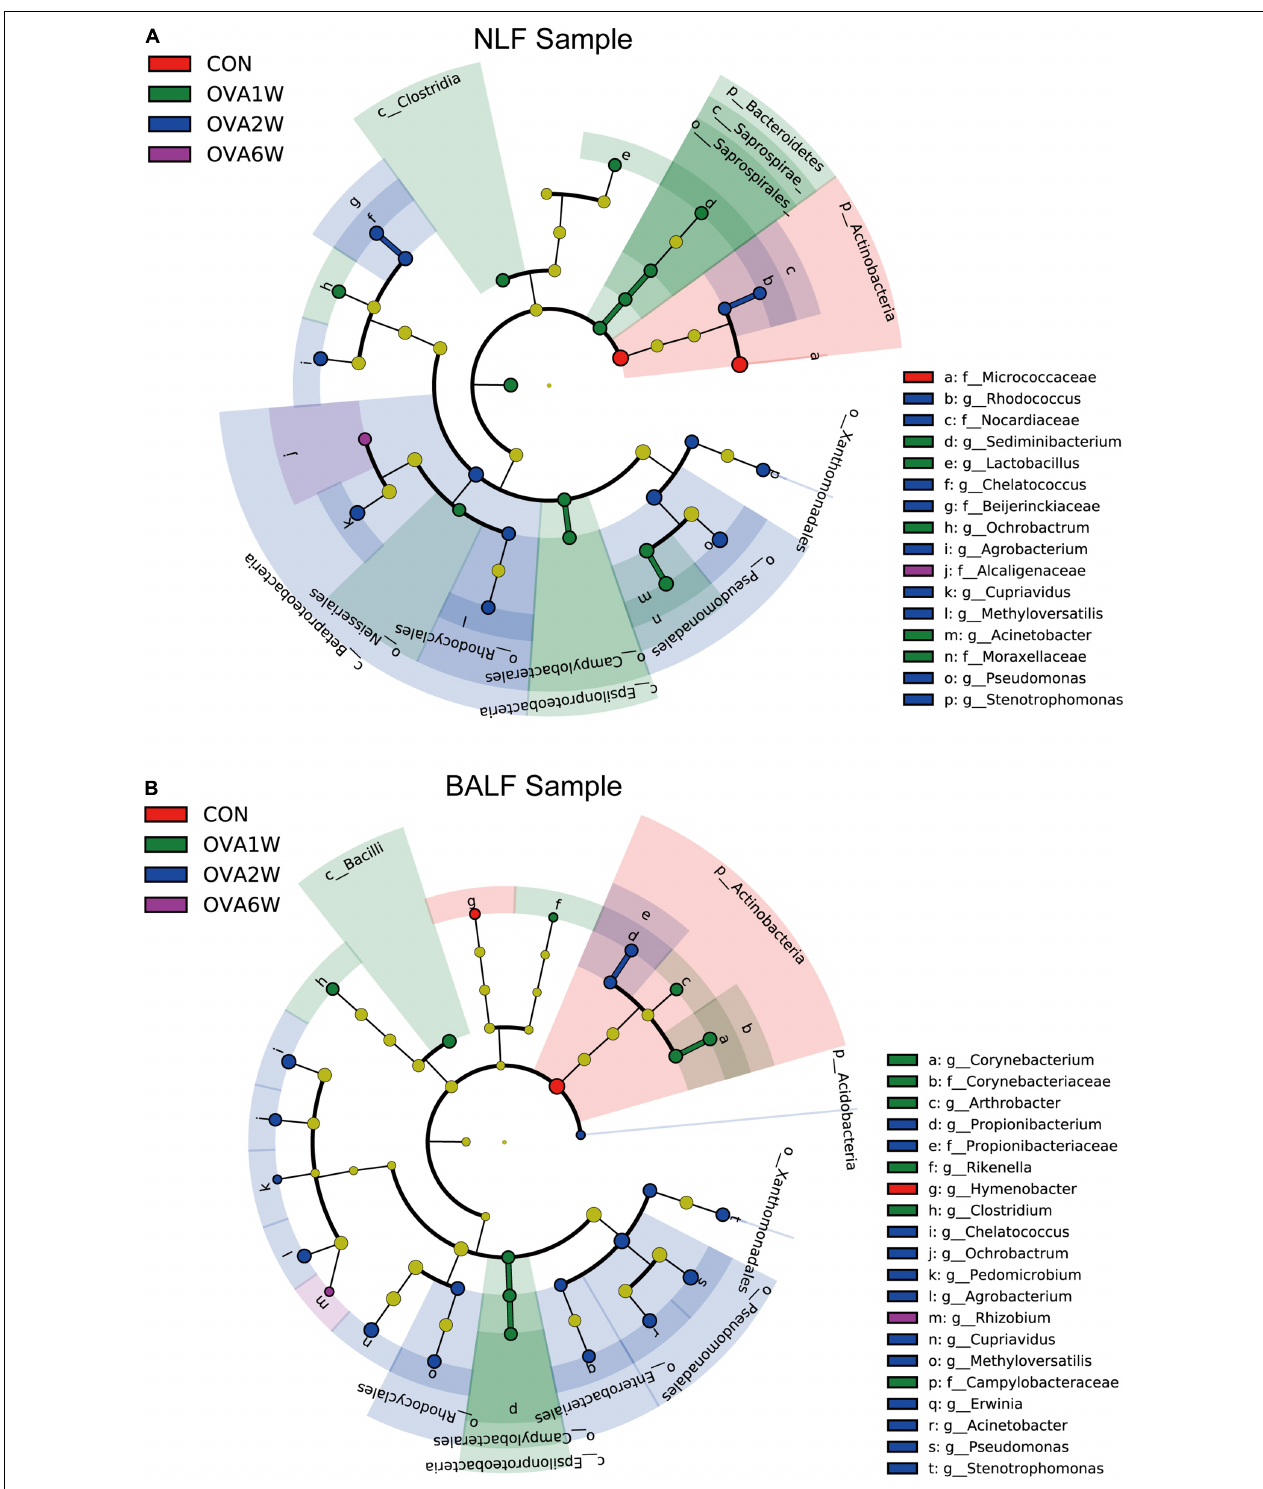
FIGURE 5 | Different abundances of bacterial communities in the respiratory samples, as indicated in LEfSe analysis. The differences are indicated by the color of over-represented taxa: red indicating control mice, green indicating OVA1W mice, blue indicating OVA2W mice and purple indicating OVA6W mice. (A) Different abundances of bacterial communities in the URT (NLF samples) with LDA scores > 2.6. (B) Different abundances of bacterial communities in the LRT (BALF samples) with LDA scores > 2.5. The circles represent phylogenetic levels from phylum (innermost circle) to genera (outermost circle). n = 5 in each group; adjusted P values ≤